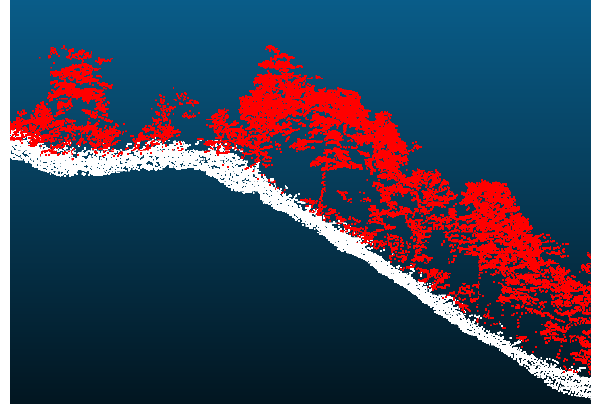
Figure 5. Pre-processed points (white) and original point (red)